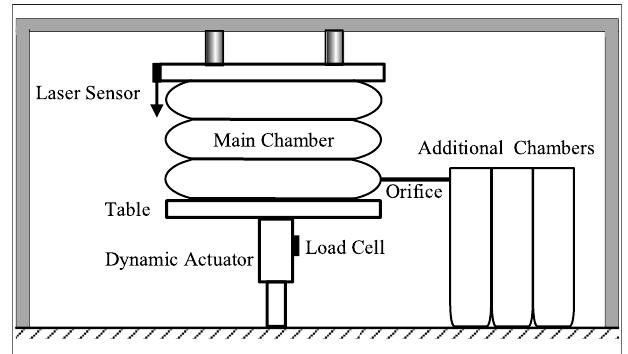
FIGURE 3 | Illustration of experimental equipment.